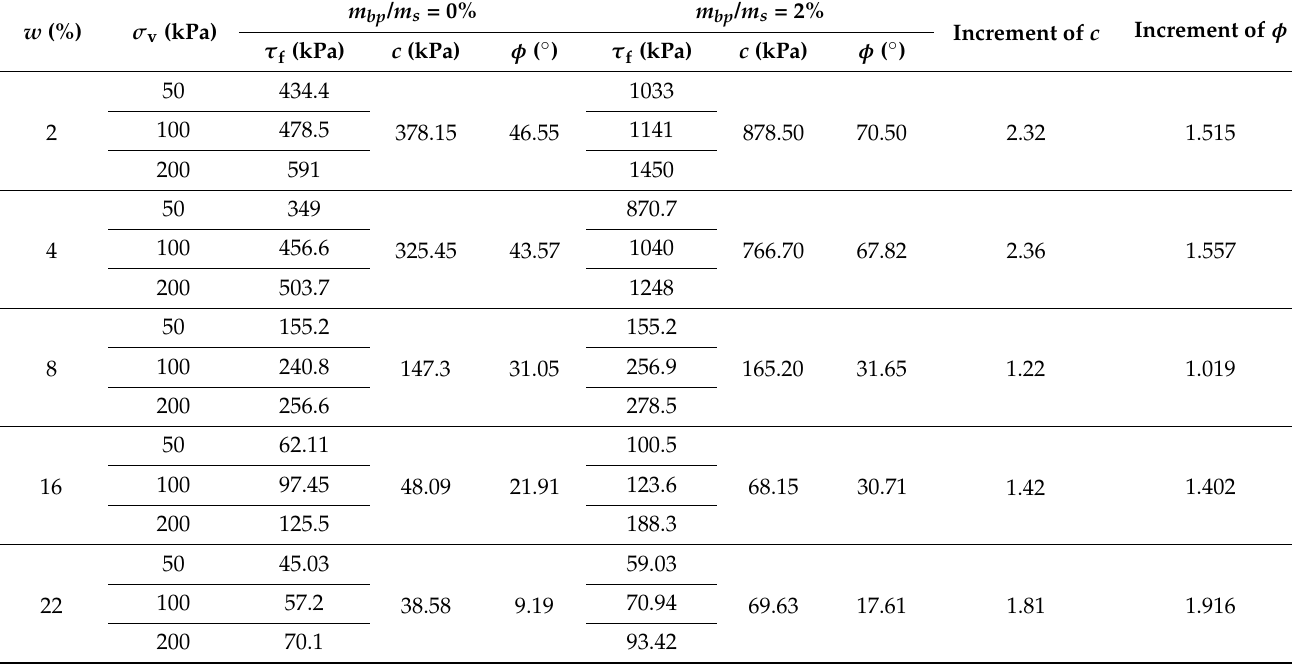
Table 3. Strength properties of the XG-silt specimens under different conditions ( m bp / m s